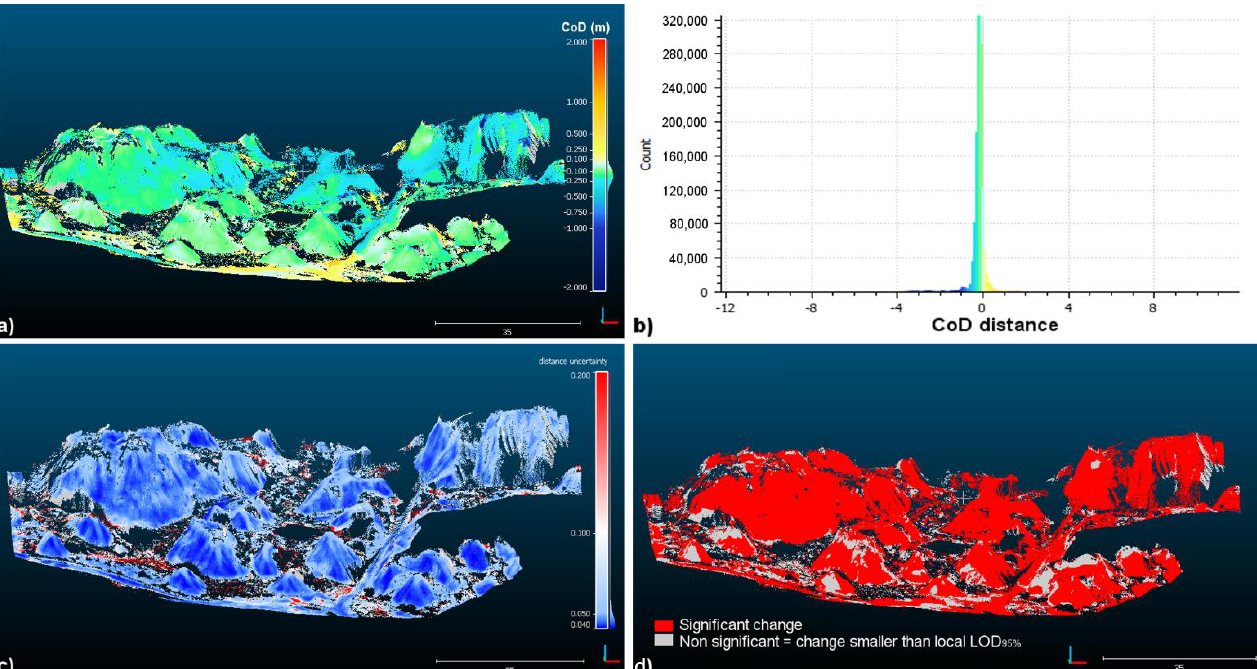
Figure 3. Topographical changes detected in the biancane point clouds; all numeric values are in metres; ( a ) south-side view of the CoD; ( b ) histogram showing the distribution of the values in ( a ); ( c ) uncertainty values shown as level of change detection at 95%; ( d ) statistically significant changes [55] derived from the combination of the CoD ( a ) and uncertainty ( c ).